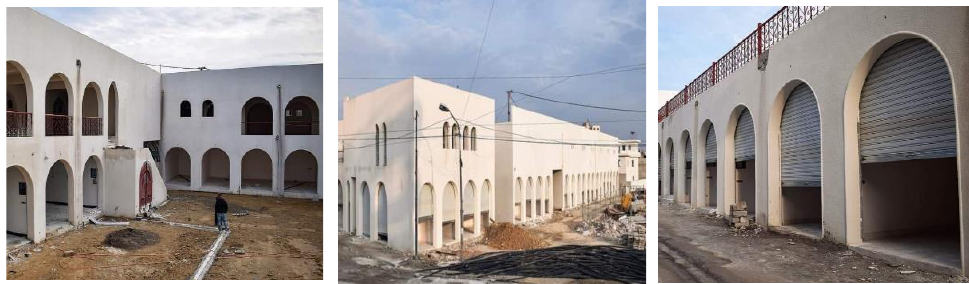
Figure 10. The reconstruction stage of Khan Hamo Qaddo. (photo credit: Nineveh Governorate and the Municipality of Mosul, Department of Media) [28].